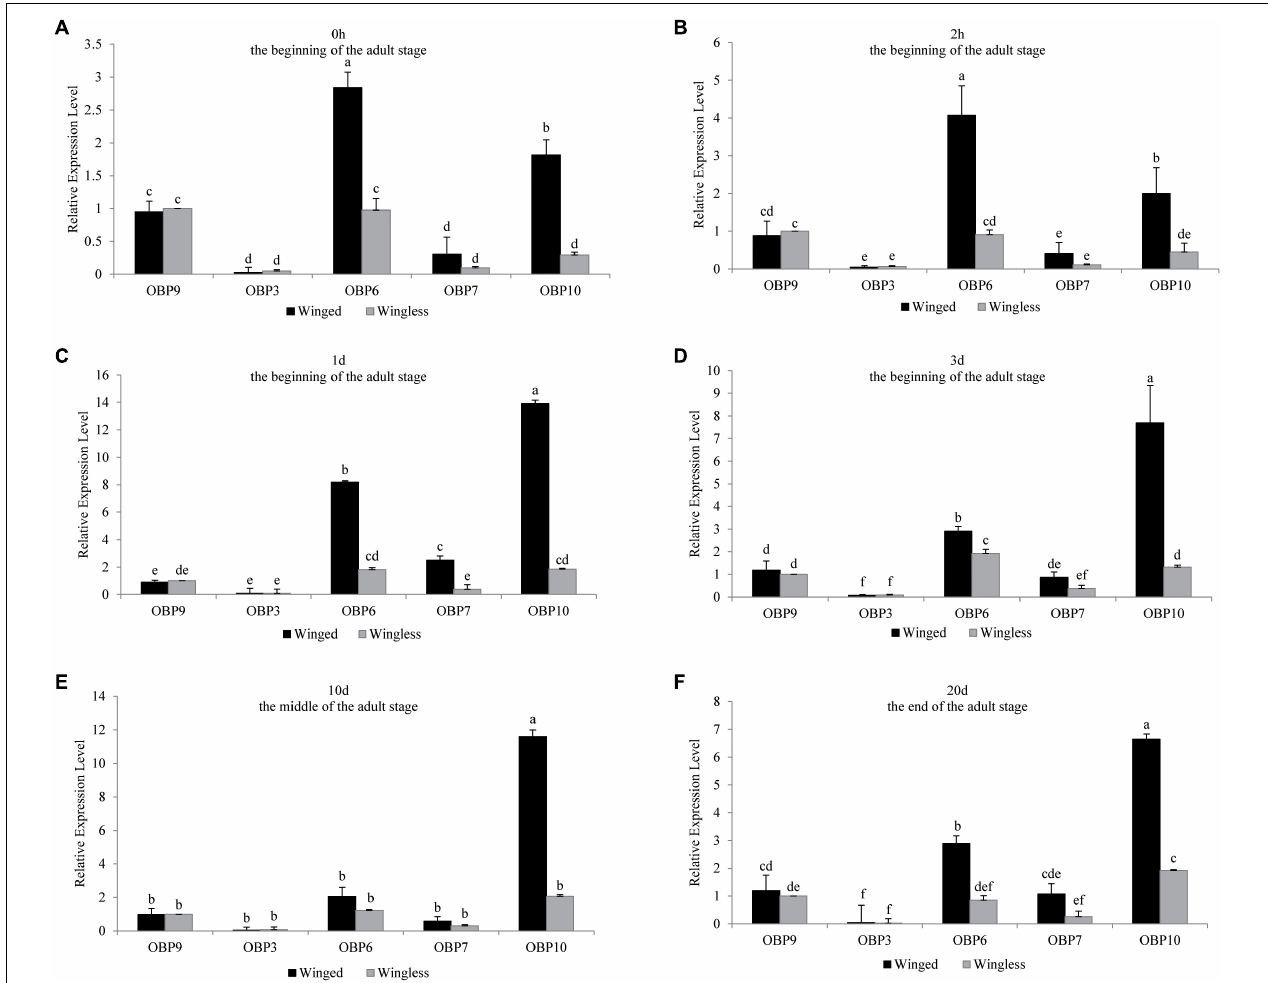
FIGURE 2 | OBP3/6/7/9/10 expression at each time point (0 h, 1 d, 3 d, 10 d, and 20 d) in S. miscanthi . Fold changes are relative to the antennal transcript levels of OBP9 in the wingless morph at the corresponding time point. Differences in mean transcript levels were detected using one-way ANOVA, followed by Duncan’s multiple range test. Different letters over bars indicate significant differences ( p < 0.05). Winged, antennae of winged aphid; Wingless, antennae of wingless aphid; Beginning, middle, end, the adult stage after emergence was divided into three parts, namely, beginning (within 3 d), middle (10 d), and end (20